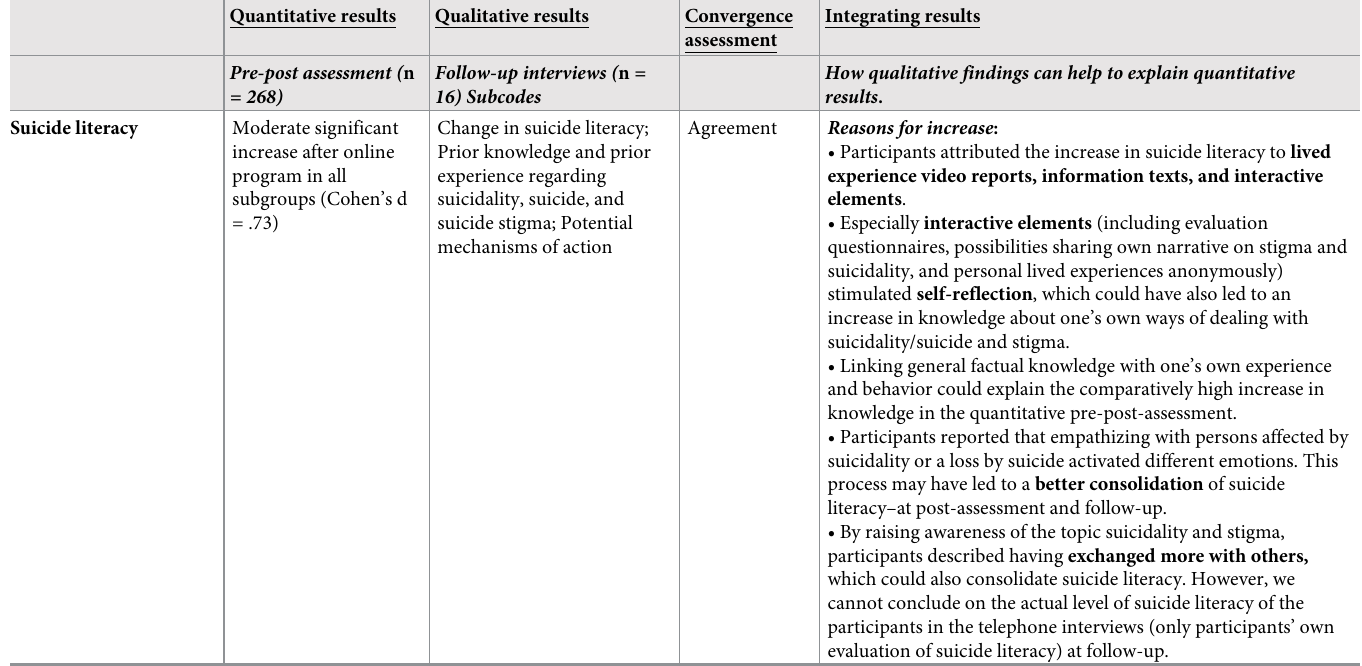
Table 6. Joint display including a convergence assessment of quantitative and qualitative evaluation results of the online suicide prevention program 8 lives . Quantitative